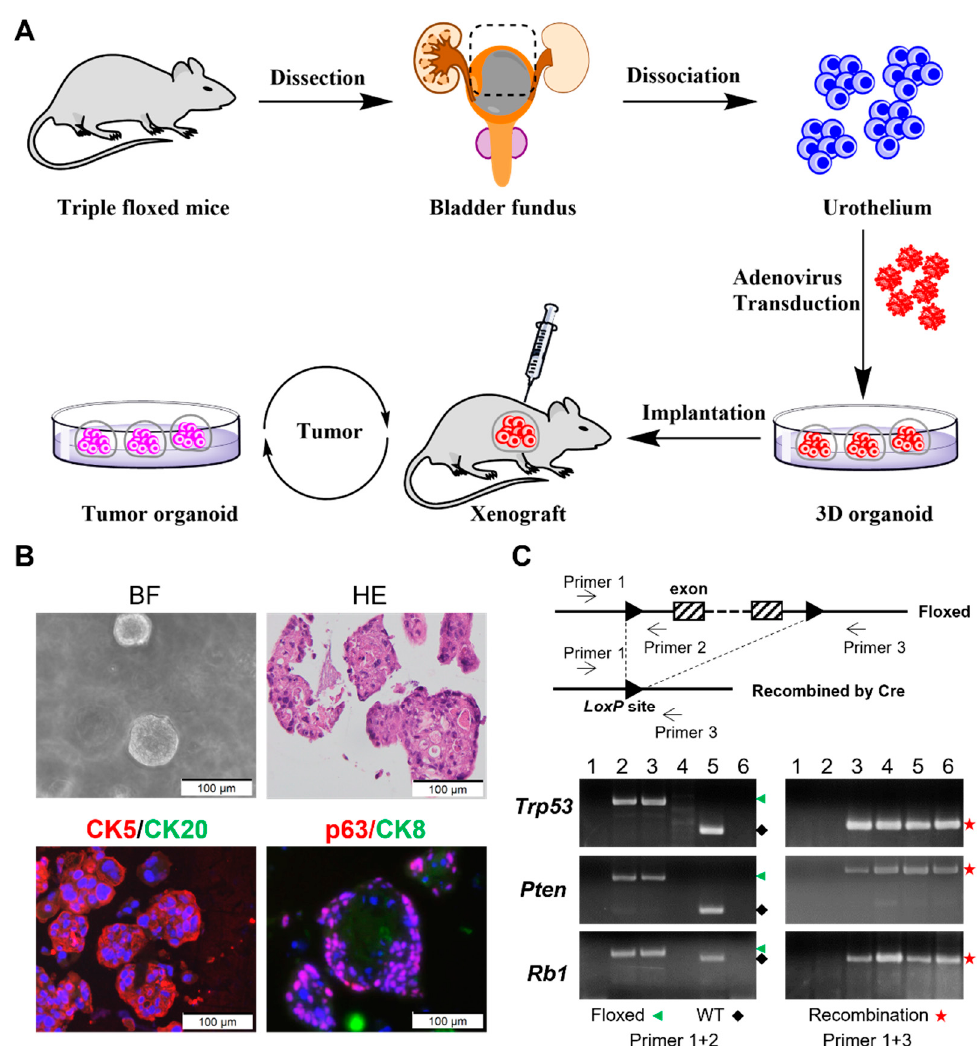
Figure 1. The generation and characterization of TKO organoids created by ex vivo A5CMVCre transduction of urothelial cells. ( A ) The workflow of TKO organoid generation via ex vivo Cre recombination by Ad5CMVCre transduction. ( B ) A bright-field (BF) image of organoids, H&E, and the immunofluorescence staining of organoid paraffin sections. ( C ) The PCR validation of floxed/WT and Cre recombined alleles in indicated samples. PCR bands were stained with ethidium bromide. The genomic structure of floxed allele and recombined allele with LoxP sites is shown. Primer 1 and 2 were used for floxed and WT alleles, whereas primer 1 and 3 were used for recombined alleles. Genotyping using triple-floxed mouse tail DNA (lane 2) revealed floxed alleles (green) of Trp53 , Pten, and Rb1 and no recombination alleles (red). WT alleles (black) were detected only in WT stroma cells from the host in TKO subcutaneous tumor (lane 5) but not detected in TKO primary organoid (lane 4) or tumor derived organoid after 7 serial passages (lane 6). The recombination alleles (red) were detected in the TKO organoid (4), xenograft tumor (5), and tumor-derived organoid (6). A mixture of cells with floxed and recombination alleles served as a positive control (lane 3), and H 2 O served as a negative control (lane 1). Original DNA gel figures with DNA ladders and the expected size of PCR bands are shown in Supplemental Figure S1.